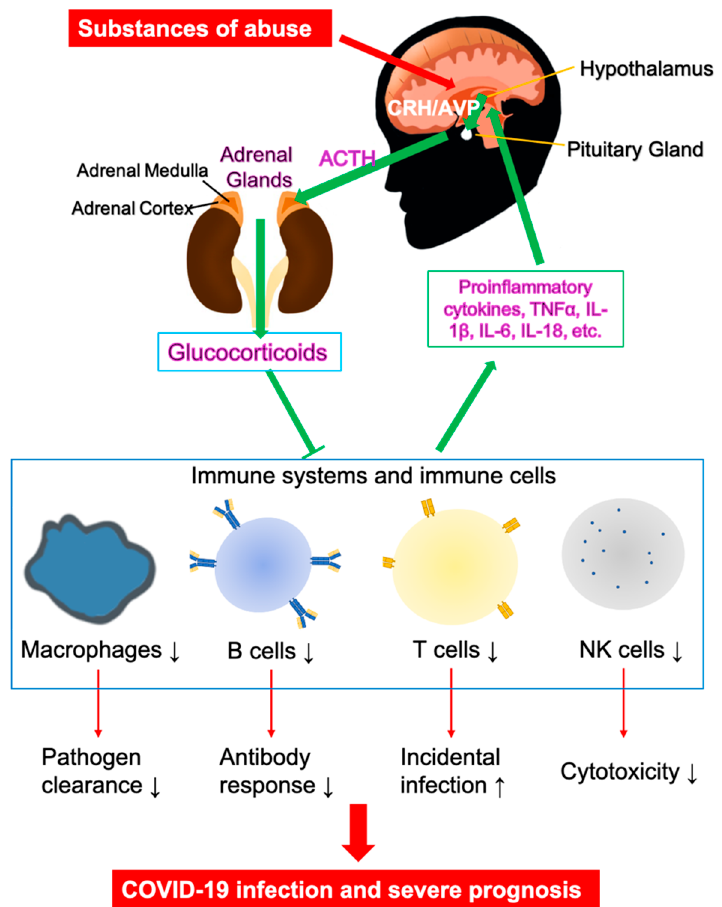
Figure 3. Bidirectional communication between the brain and the immune system. The HPA axis: upon activation (cytokines, pathogens, etc.), the hypothalamus in the brain produces CRH and AVP, activating anterior pituitary, which secretes ACTH. ACTH circulates with general blood stream to reach adrenal gland, which synthesizes the anti-inflammatory molecule, glucocorticoids. Glucocorticoids suppress the immune system and the expression of proinflammatory cytokines, which concludes the negative feedback and turns off the HPA axis. Glucocorticoids suppress the activities of various immune cells, including macrophages, dendritic cells, and T cells, which are responsible for cytokine release. The immunosuppression also involves inhibition of NK cells, B cells, and T cells for reduced cytotoxicity, antibody production, and T cell-mediated immune responses. Substances of abuse alter the HPA axis. Excessive production of glucocorticoids suppresses immune responses to viral infection, leading to high incidences of infection and severe infection in COVID-19. Arrows indicate stimulation; blunted arrows indicate inhibition.